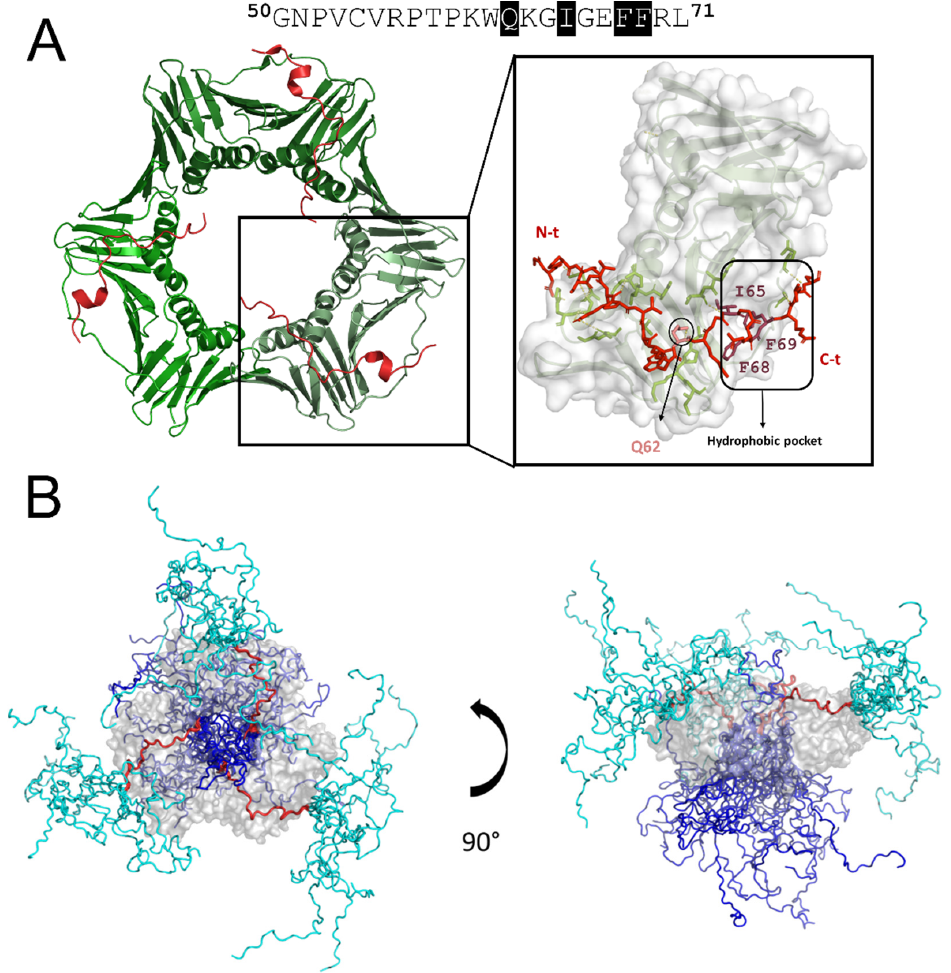
Figure 4. The central region of p15 binds PCNA, while the N- and C-terminal tails remain disordered. ( A ) The crystal structure of a PCNA trimer bound to three p15 41–72 fragments (PDB code: 6GWS) in cartoon representation. PCNA is colored in a different tone of green, while p15 fragments are shown in red. On the right, a zoom view of the binding interface is shown, where polar contacts between PCNA and p15 are marked by discontinuous yellow lines. p15 peptide and PCNA are represented by sticks and cartoons, respectively. Only those residues of PCNA that interact with p15 are drawn as sticks. The surface representation of the monomer of PCNA is shown with transparency. ( B ) A model of the full-length p15–PCNA complex. Front and side views of 10 modelled structures of the p15–PCNA complex based on experimental data. PCNA is shown as a gray surface and p15 as ribbons, with the central region colored in red, and the added disordered N- and C-terminal extensions colored in cyan and blue, respectively. In one of the 10 selected complex models, one p15 N-terminus folds back towards the front face of PCNA instead of passing through the hole.